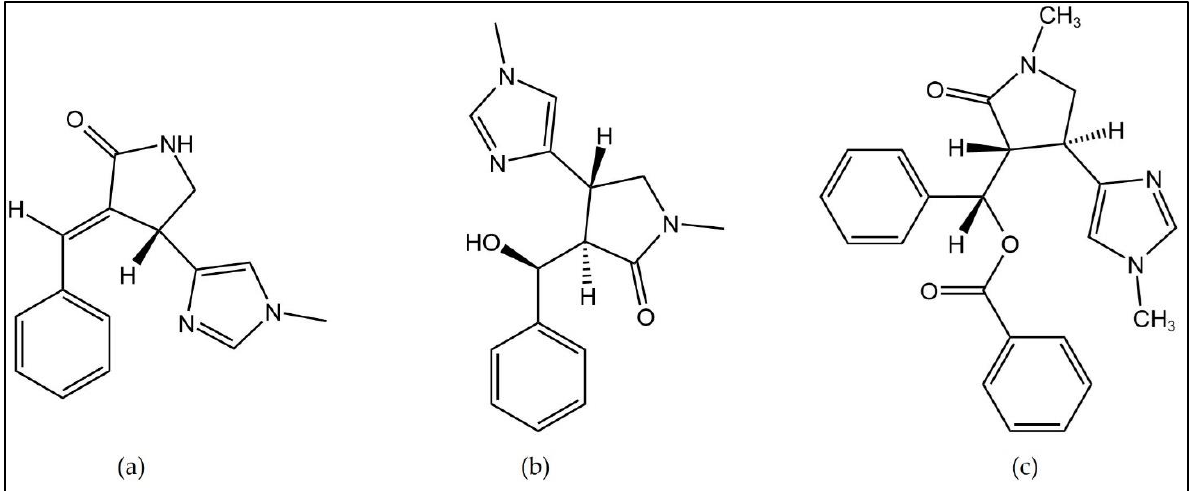
Figure 4. Examples of Imidazole alkaloids ( a ) anantine, ( b ) cynometrine, and ( c ) cynodine identified on Cynometra species.